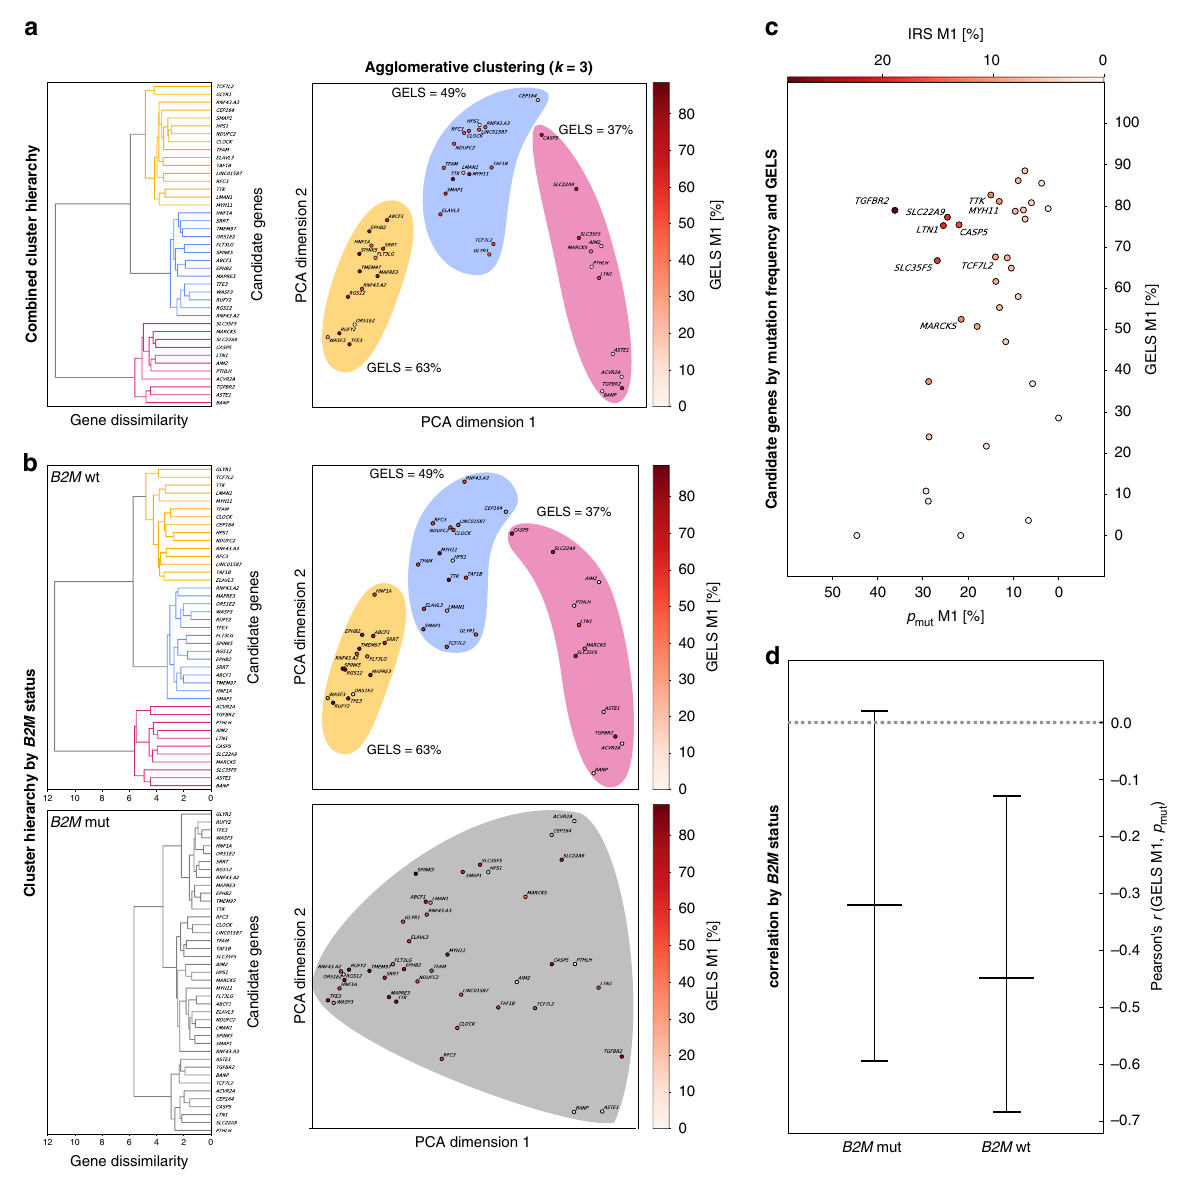
Fig. 4 Evidence of immune selection from cMS mutation patterns and GELS. a Hierarchical clustering of cMS candidates on all tumor samples using frameshift abundance features. The full clustering hierarchy is displayed as a dendrogram, showing three clusters (yellow, blue, pink). The same clusters are visualized using RBF kernel PCA with two principal components and colored by their GELS. The three clusters display a trend in their mean GELS, with increasing values from pink to blue to yellow. b Hierarchical clustering of cMS on features split by B2M status, with wild type at the top and mutated at the bottom. The full hierarchy is displayed as a dendrogram for both feature sets. In contrast to B2M wild type, B2M -mutated features show no clustering at the computed clustering dissimilarity threshold of 5.7. The same data are again shown using RBF kernel PCA with two principal components. c Mutational frequency resulting from one base pair deletions (m1) is shown on the y axis against the GELS of the resulting M1 frameshift peptides ( x axis). For GELS, all predicted epitopes (IC 50 < 500 nM) were accounted for, with an assumed probability for a binder to be a true positive of p binding = 50%. Every bubble represents one candidate. The gradient intensity of the bubbles shows IRS, with white color representing a low IRS, while dark red displays a high IRS. All candidates with an IRS of ≥ 10% are annotated. d Correlation between the number of predicted epitopes in cMS mutation-induced frameshift peptides and the frequency of the respective cMS mutations in MSI colorectal cancer separated by B2M mutation status. Pearson ’ s r is shown on the y axis, while the different groups of tumors are shown on the x axis. Centers indicate Pearson ’ s r , whiskers indicate 95% con fi dence intervals. A signi fi cant inverse correlation was observed showing r = − 0.42, p = 0.0149 at n = 41 candidates for 99 MSI colorectal cancers with wild-type B2M , with a conservative estimate of predicted epitope fi delity of p binding = 50%, indicating that high GELS was related to lower mutation frequency (for analysis of relative mutation frequencies, see also Supplementary Fig. attack of the immune system. Such cMS candidates with high frameshift peptides being presented to the immune system, we GELS and mutation frequencies should be of great relevance for de fi ned an immune relevance score (IRS), which combines the interaction between the immune system and MMR- GELS with the mutation frequency in tumors computed via de fi cient tumor cells. To simultaneously account for mutation ReFrame (see “ Methods ” section “ Computation of immunolo- frequency and GELS as factors in fl uencing the likelihood of gical scores ” ).